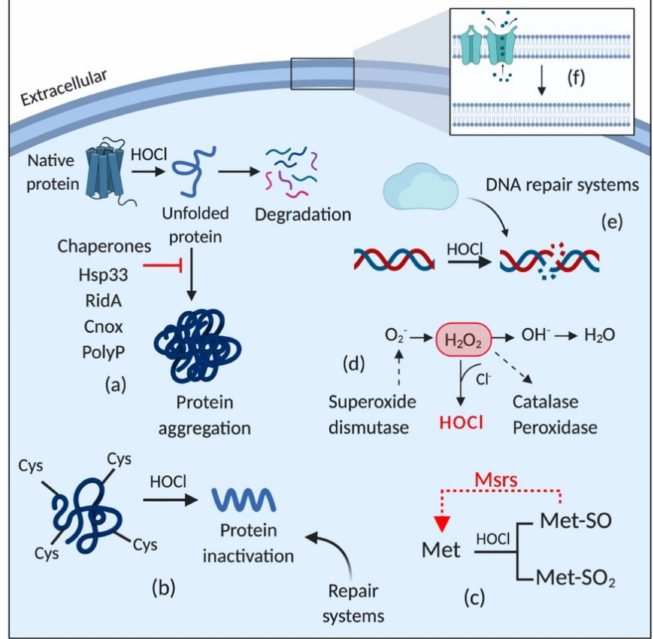
Figure 4. Schematic representation of the stress response triggered by HOCl exposure. HOCl activates ( a ) chaperones; induces the expression of ( b ) protein repair systems, especially for those in which cysteine and ( c ) methionine are the main target amino acids; ( d ) detoxifying enzymes; ( e ) DNA repair systems; and ( f ) induces changes in membrane properties, such as downregulating porins, reducing permeability and increasing hydrophobicity. HOCl: hypochlorous acid; H 2 O 2 : hydrogen peroxide; Cys: cysteine; Met: methionine; Met-SO: methionine sulfoxide; Met-SO2: methionine sulfone; Msrs: methionine sulfoxide